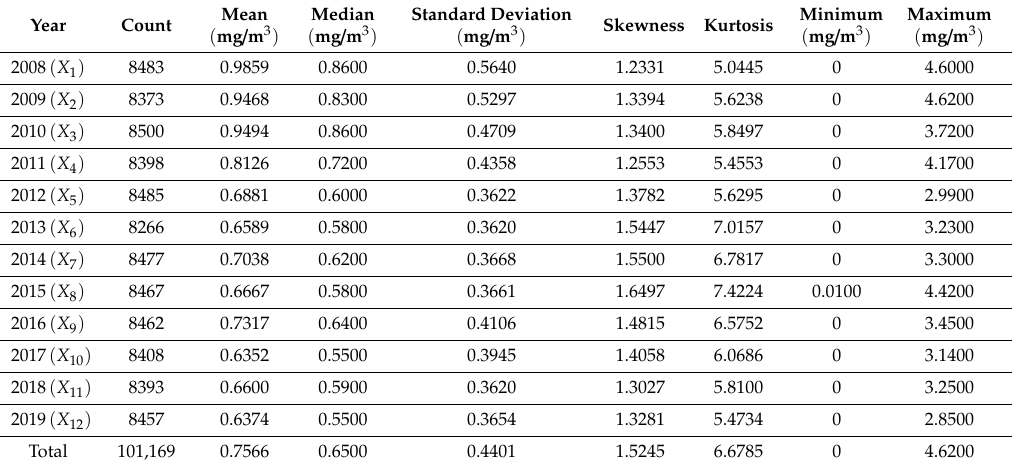
Table 1. Summary statistics of the CO concentration measurements.